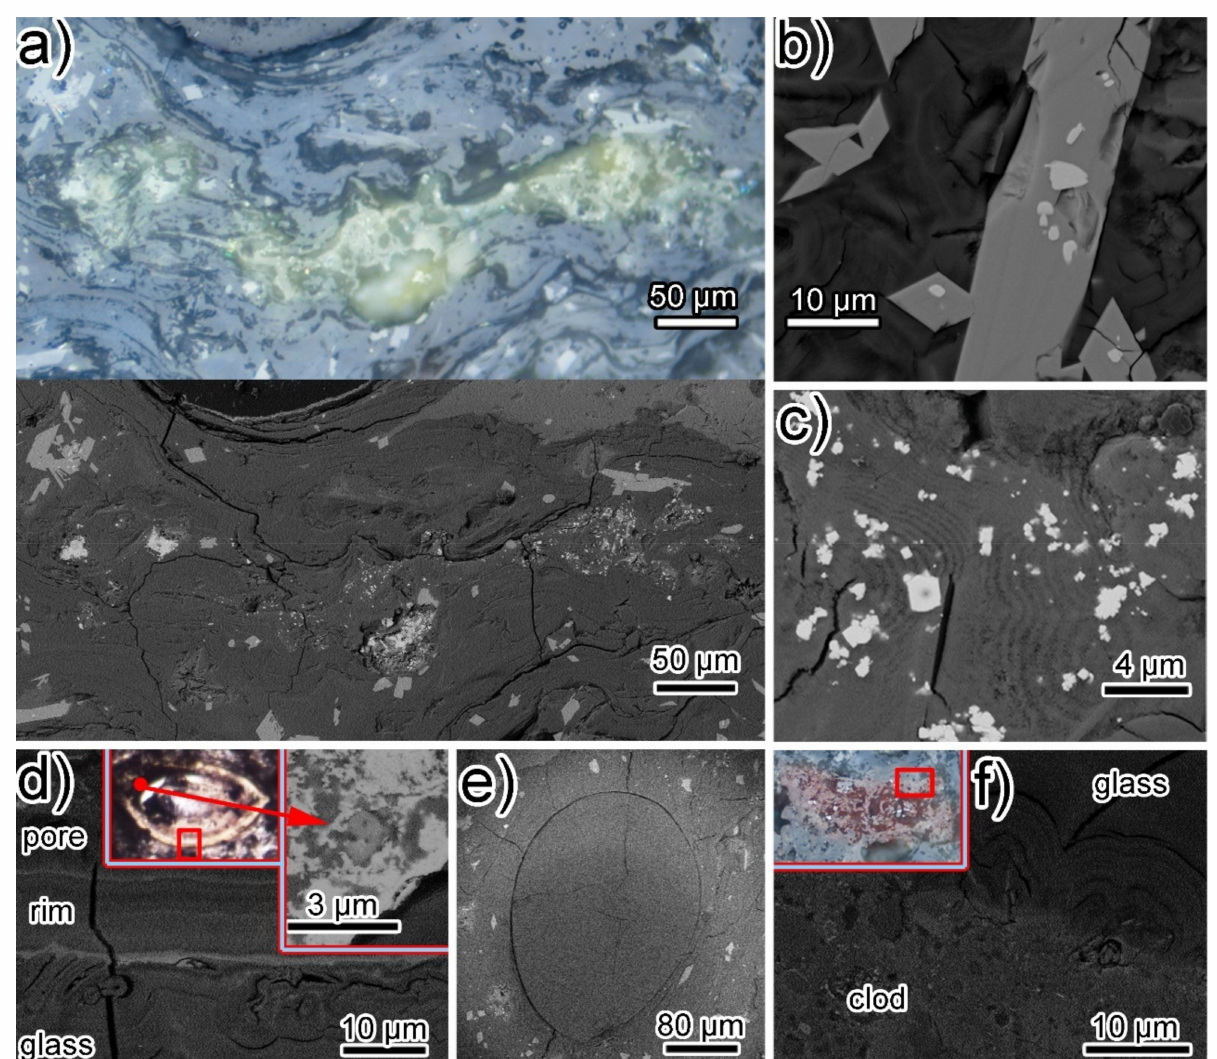
Figure 9. Detailed images of features found within the thin section of the sampled green glass tessera #12 from the Circus mosaic: ( a ) Microcrystals with gray and yellowish reflectance as seen in POM in RL mode (top) and the same area seen by SEM (bottom); ( b ) zoomed SEM image of crystals of gray reflectance including brighter domains; ( c ) zoomed SEM image of crystals of yellowish reflectance; ( d ) SEM image of the glass matrix and the rim of a large pore (central inset, PPL POM image of the pore with indication of the SEM viewed areas, and, inset on the right, SEM image of the opaque pore-filling); ( e ) SEM image of a large filled pore deprived of rim; ( f ) SEM image of the glass matrix in contact with a clod relict (inset. POM (in RL mode) image of the whole reddish clod with indication of the SEM viewed